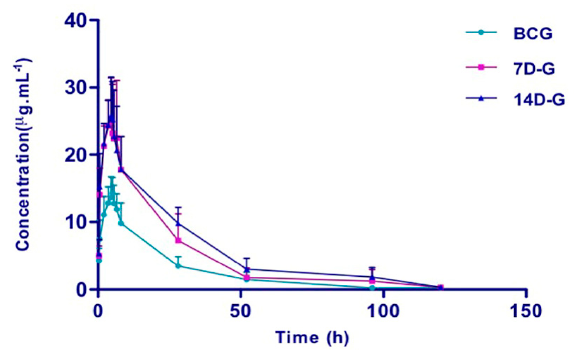
Figure 2. The mean plasma concentration-time curves of warfarin (2.0 mg/kg, i.g.) in the different groups ( n = 6). BCG, blank control group (0.9% sodium chloride solution for 10 days); 7D-G, short-period group (5 mL/kg of SGI concentrated solution, iv., once daily for consecutive 7 days); 14D-G, long-period group (5 mL/kg of SGI concentrated solution, iv, once daily for consecutive 14 days). Error bars represent SD.